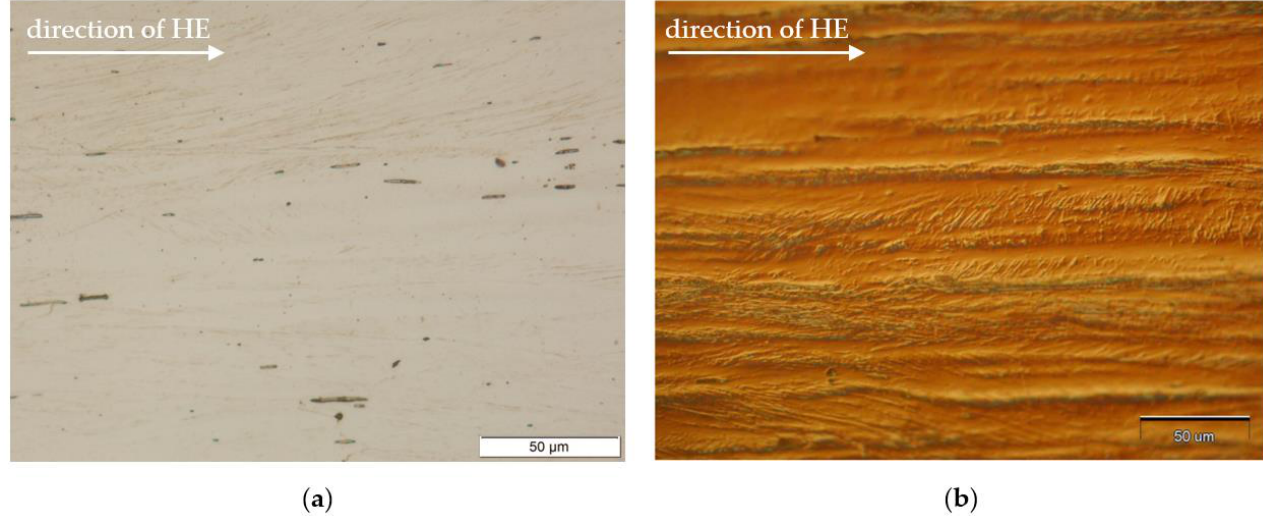
Figure 2. Micrograph of the microstructure of the base material after one-pass HE, longitudinal cross-section, ( a ) optical observation ( b ) with Nomar—Differential Interference Contrast (DIC).